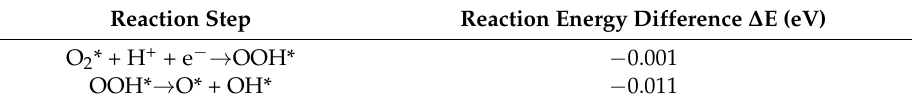
Table 3. The calculated reaction energy difference ( ∆ E) for adsorbed O 2 hydrogenation to OOH. It can be seen that OOH species may dissociate into O + OH. The reaction energy difference is calculated by ∆ E = E − E FS IS